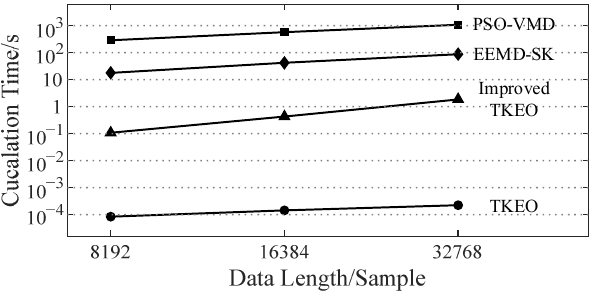
Figure 10. The average calculation time of mentioned methods (for the signal in Figure 9b).